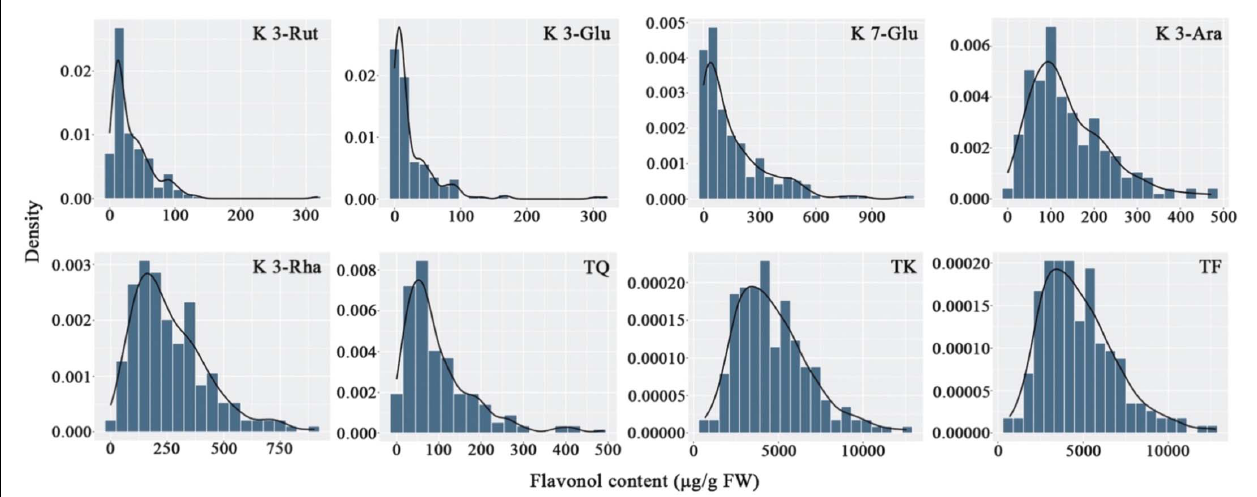
FIGURE 2 | Frequency distribution of flavonol contents in the tetraploid rose YS population. K 3-Rut, kaempferol 3- O -rutinoside; K 3-Glu, kaempferol 3- O -glucoside; K 7-Glu, kaempferol 7- O -glucoside; K 3-Ara, kaempferol 3- O -arabinoside; K 3-Rha, kaempferol 3- O -rhamnoside; TQ, total quercetin; TK, total kaempferol; TF, total flavonol.